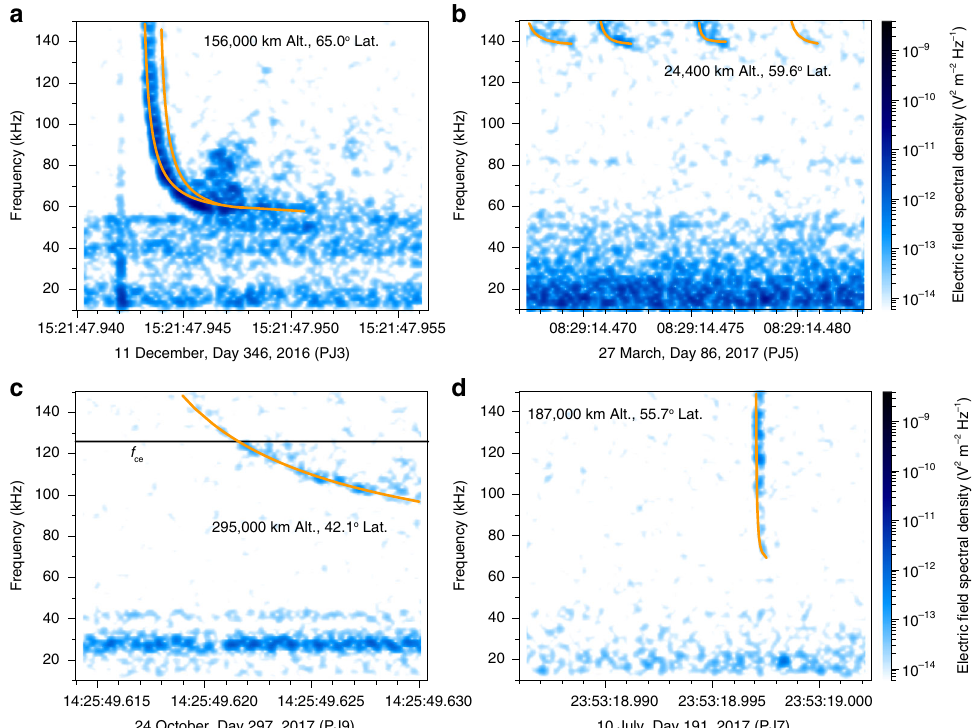
Fig. 1 Four examples of Jupiter dispersed pulses (JDPs). These spectrograms were converted from 16.384-ms waveform snapshots. The orange curves are fi tted with three free parameters D , f C via the O mode propagation model (Methods and Supplementary Fig. 1). There are a pair of JDPs ( a ) with a pe , and pulse-to-pulse interval of 0.7 ms, four individual JDPs ( b ) with a high cutoff frequency ( f pe = 138 kHz), one JDP ( c ) with a large dispersion ( D/c = 54 ms), and one JDP ( d ) with a short dispersion ( D/c = 0.18 ms). The black line in c shows the local electron cyclotron frequency f ce computed from the Juno ’ s on- board magnetometer 29 , while f ce in the other examples is well above the upper frequency range of the LFR-Hi burst mode, 150